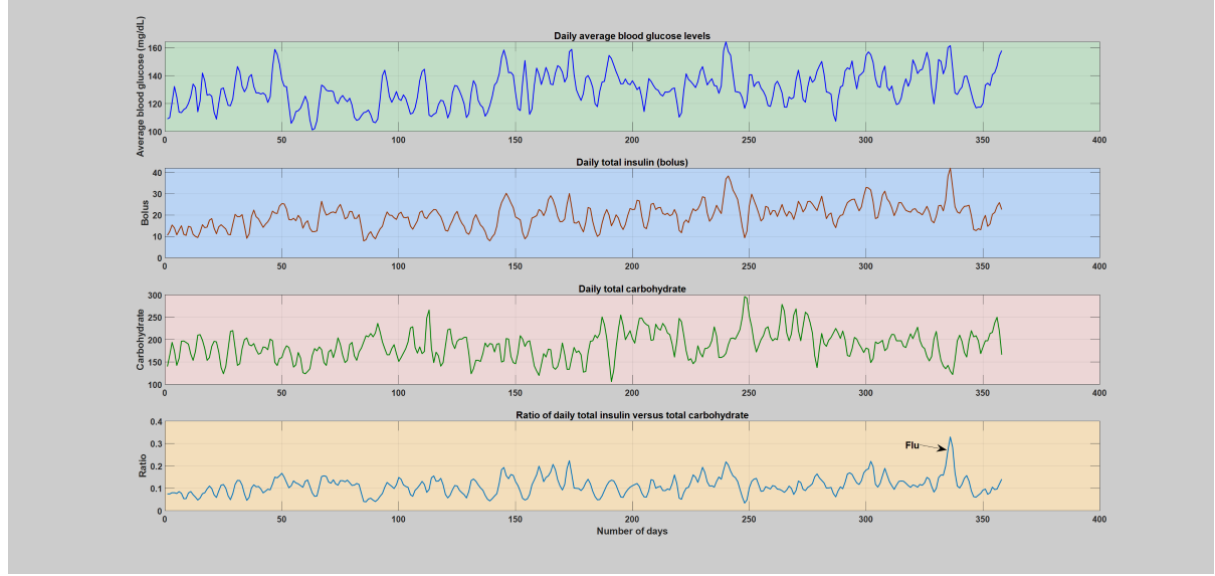
Figure 9. Daily analysis of the third infection case (flu). The figure depicts variation of average blood glucose levels, total insulin (bolus), total carbohydrate, and total insulin-to-total carbohydrate ratio. The operating point of the patient’s insulin-to-carbohydrate ratio had dramatically shifted and raised above the regular or normal days and topped around 0.4 upon midinfection